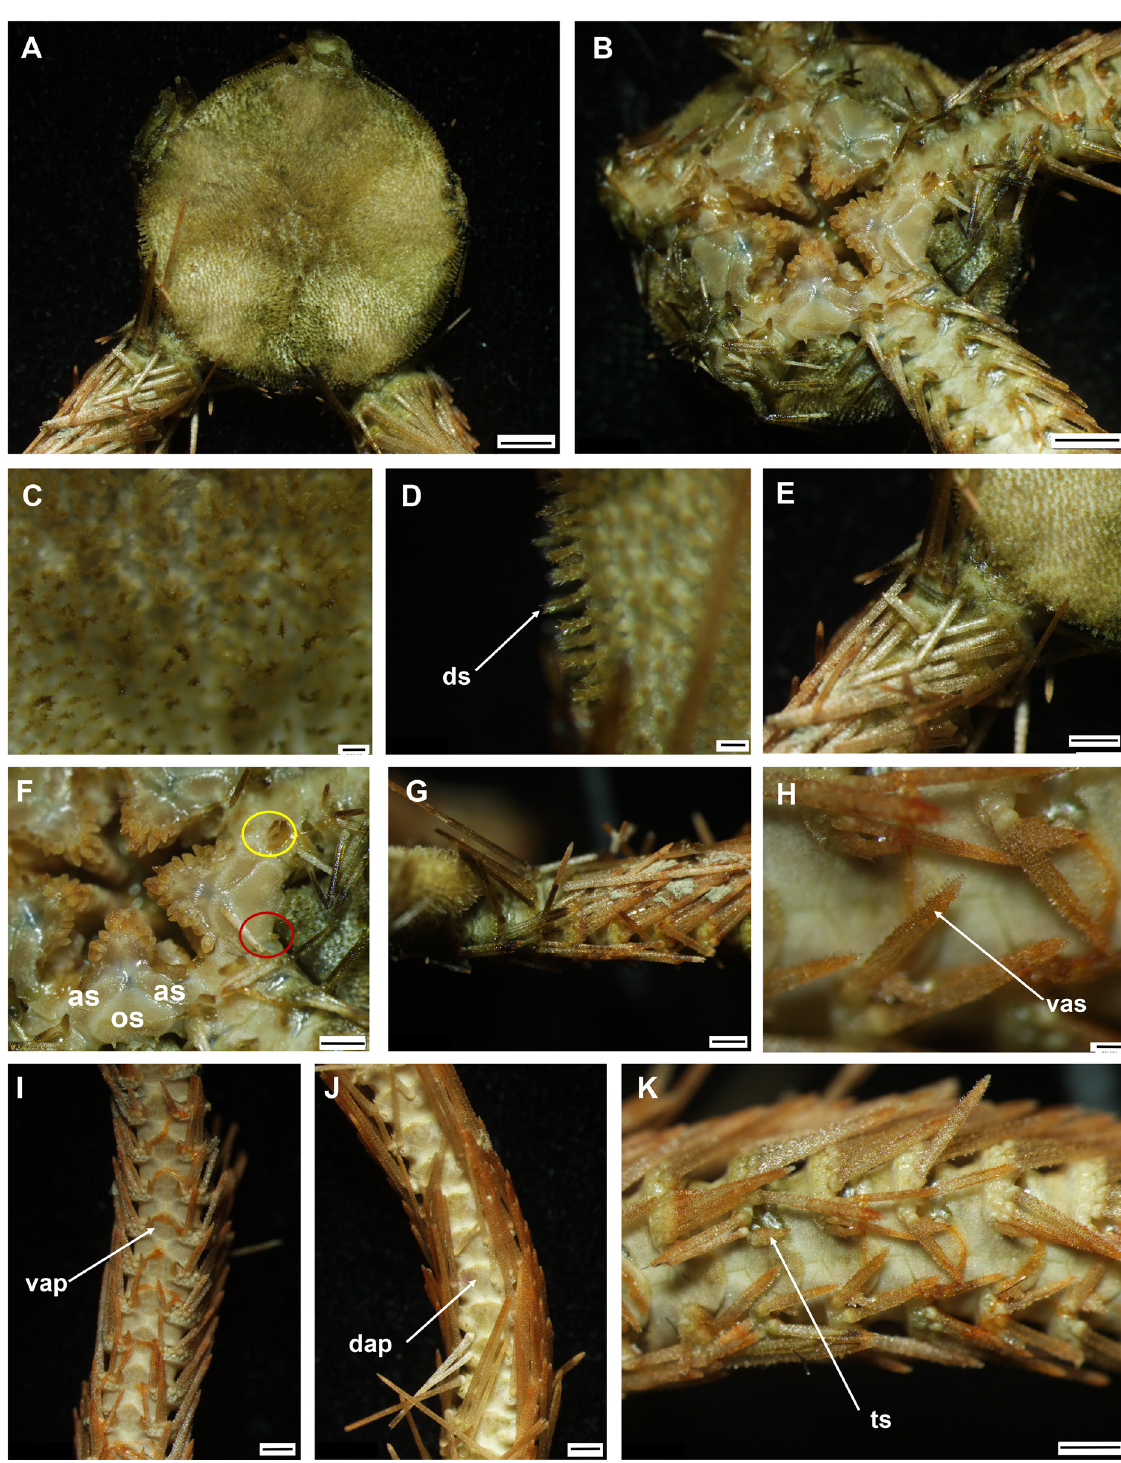
Fig. 15. Ophiotreta eximia (Koehler, 1904) (IDSSE EEB-SW0030). A . Dorsal disc. B . Ventral disc. C–D . Disc spines. E . Dorsal view of arm base. F . Oral frame (yellow circle = tentacle scales on first tentacle pore; red circle = oral shield spine). G . Lateral view of arm base. H . Ventralmost arm spine. I . Ventral arm. J . Dorsal arm. K . Ventral arm spines. Abbreviations: as = adoral shield; dap = dorsal arm plate; ds = disc spine; os = oral shield; ts = tentacle scale; vap = ventral arm plate; vas = ventral arm spine. Scale bars: A–B = 2 mm; C–D, F, H = 200 µm; E, G, I–K = 1